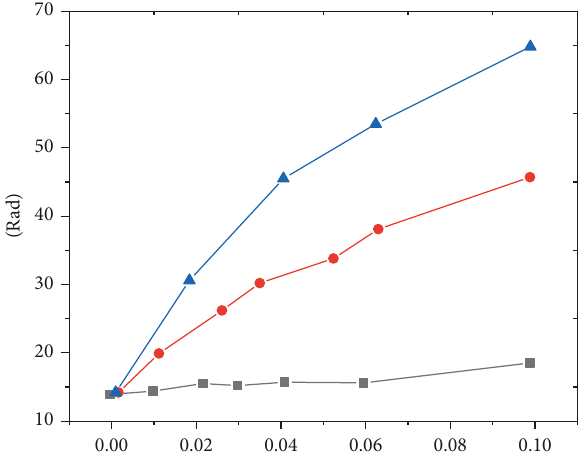
Figure 3: The influence of mass ratios μ and β on the optimal frequency of TMDI.